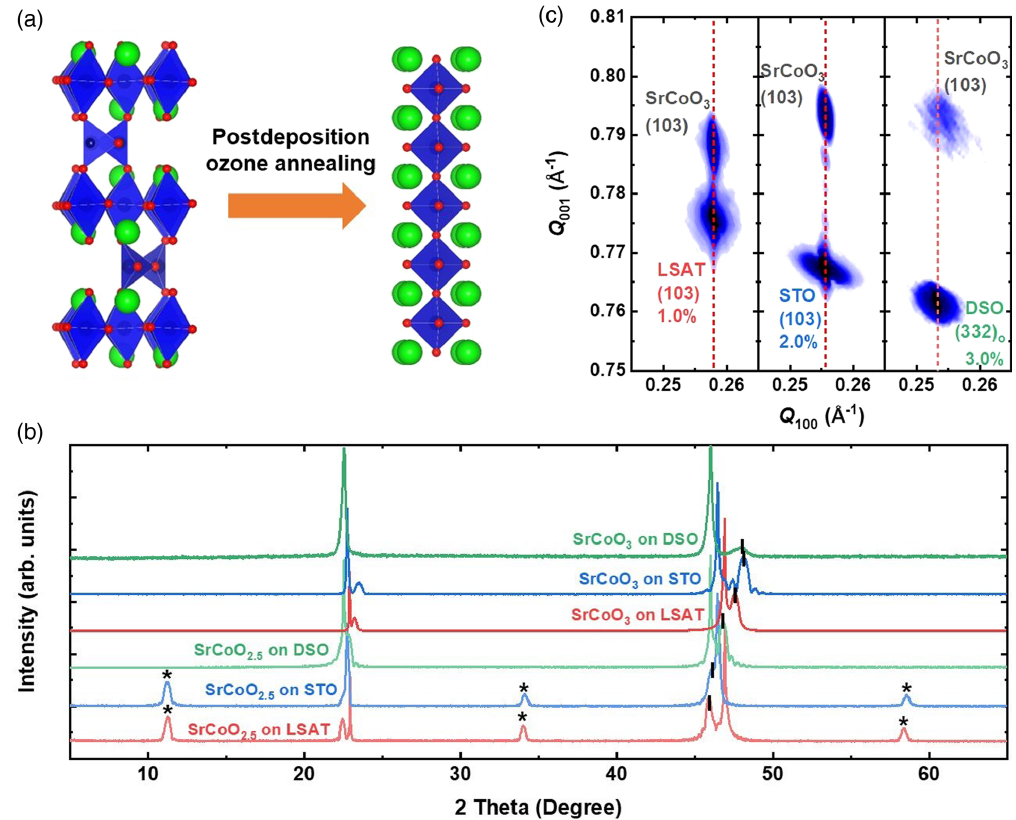
FIG. 1. Strain engineered SrCoO 3 thin films. (a) Schematic diagram of postdeposition ozone annealing induced phase transformation from SrCoO 2 to SrCoO 3 . (b) X-ray diffraction θ - 2 θ scans of pristine SrCoO 2 and postdeposition ozone annealed SrCoO 3 thin films . 5 . 5 grown on LSAT (001), STO (001), and DSO ð 110 Þ substrates (with 1.0%, 2.0%, and 3.0% tensile strain, respectively). Superlattice o peaks with star marks suggest that the oxygen-vacancy channel prefers in-plane orientation for the films grown on LSAT and STO substrates, while with postdeposition ozone annealing process the superlattice peaks are vanished for all films. (c) Reciprocal-space mapping along the pseudocubic (103) direction of SrCoO 3 thin films. The perfect alignment of the Q 100 values between the thin films and the substrates is highlighted by the red-dashed lines, suggesting that the films are coherently strained by all the